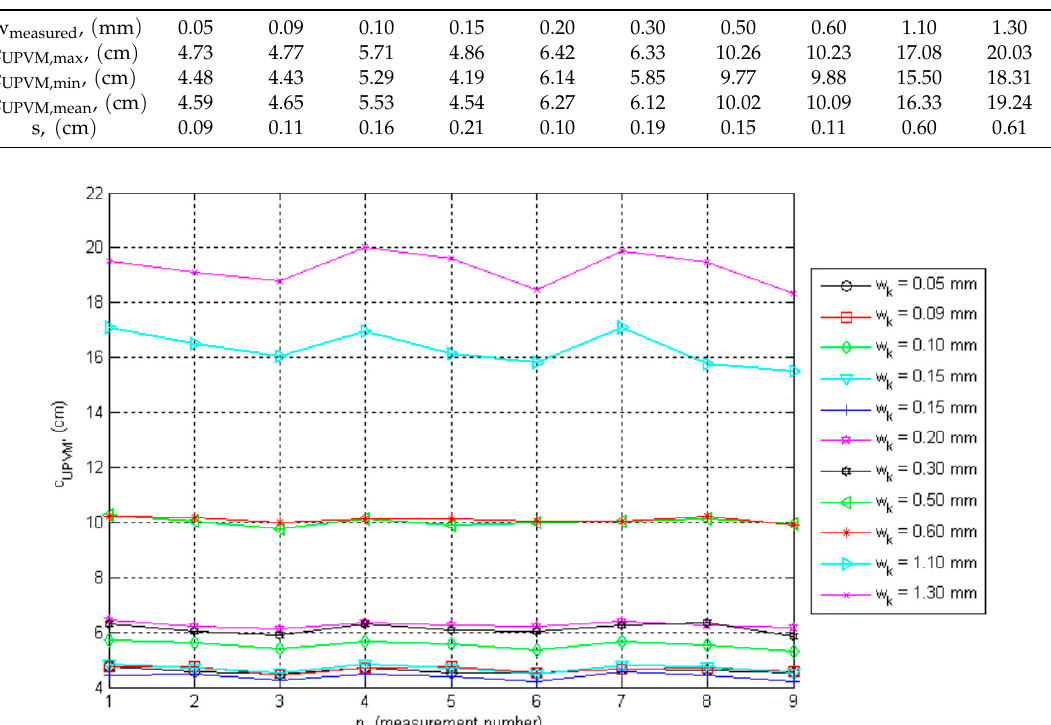
Figure 10. Crack depths determined by NDUPVM c (cid:2905)(cid:2900)(cid:2906)(cid:2897) for the corresponding crack widths.